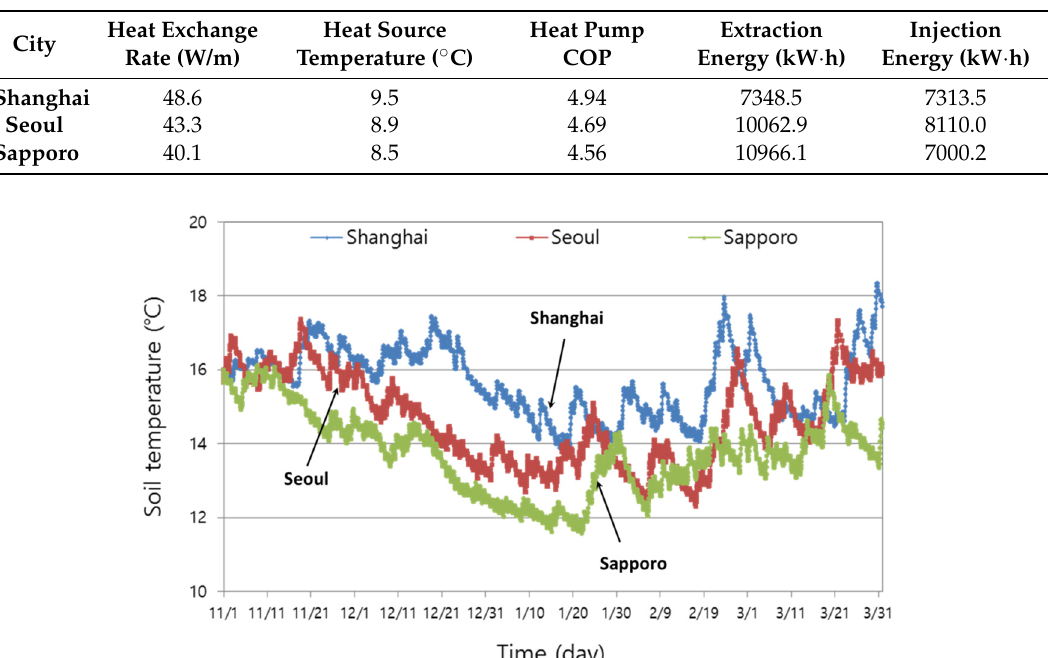
Figure 16. Soil temperature at different locations.